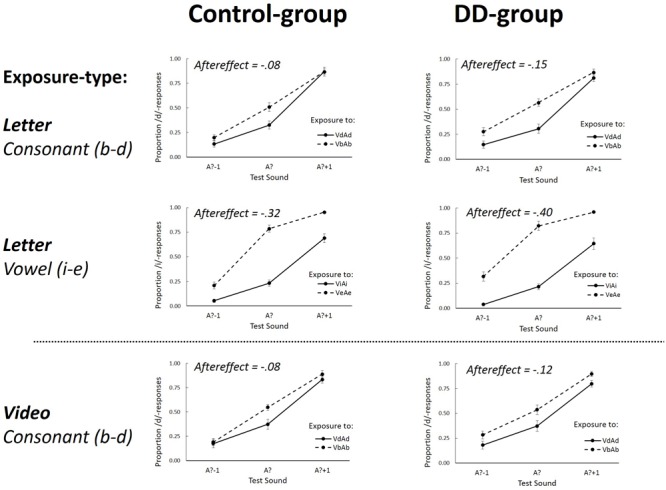
The proportion /d/ (Experiment 1, Consonant) or /i/-responses (Experiment 2, Vowel) as a function of the three different Test-sounds (A?–1; A? and A?+1) after non-ambiguous Exposure-sounds. Graphs separately depict Letter (upper four graphs) and Video (lower two graphs) Exposure-types for the Control group (left graphs) and DD group (right graphs). Aftereffects represents the overall difference between the two Exposure-tokens (VdAd – VbAb for the consonants, and ViAi–VeAe for the vowels). Error bars represent the standard errors of the mean.